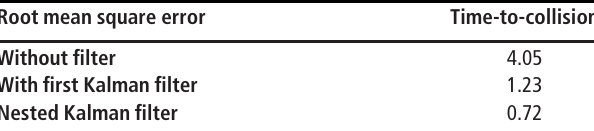
Table 2 RMSE of time-to-collision